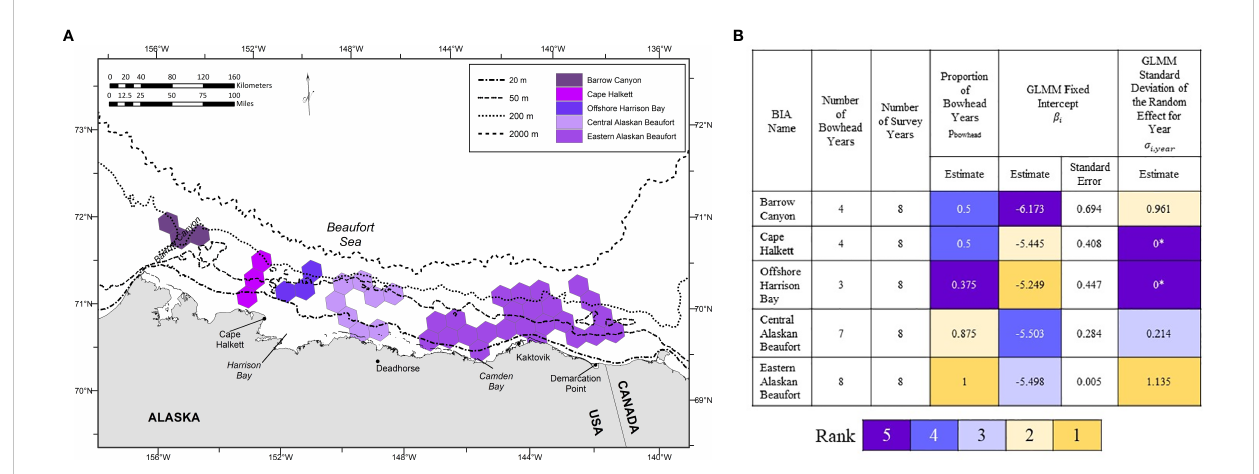
FIGURE 5 Results of the inter-annual variability analysis for each of the fi ve Biologically Important Areas (BIAs) identi fi ed in the selected scenario for bowhead whale calves in September. (A) Geographic location. (B) Summary statistics and GLMM parameter estimates. Parameter estimates are color-coded based on their associated rank, from high (rank 1) to low (rank 5). *Singular model; s i,y estimated to be